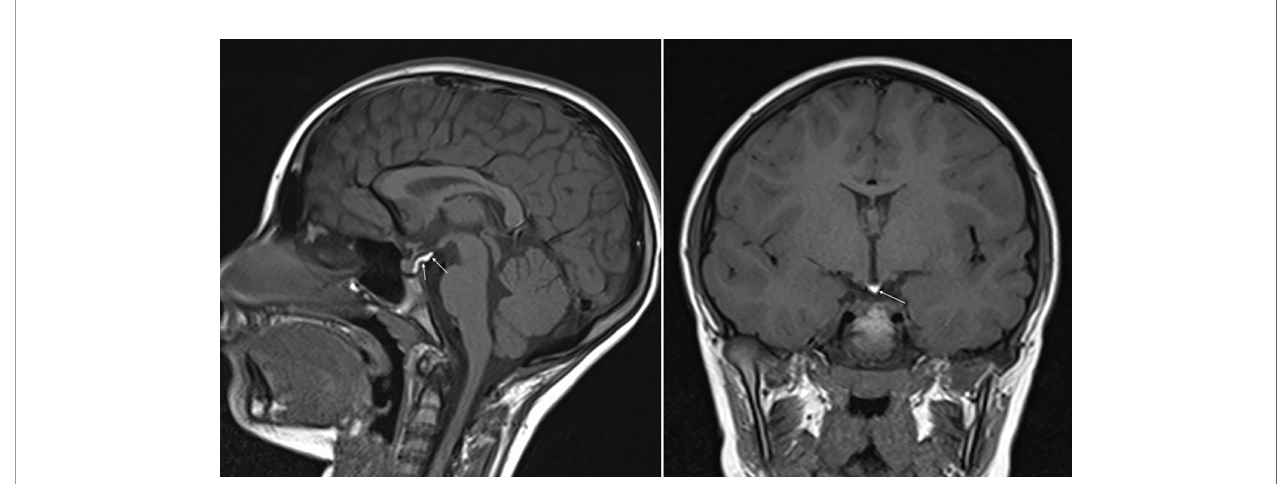
FIGURE 1 | SE T1w sequences (sagittal on the left and coronal on the right) show a posterior bright spot of neurohypophysis increased in size and stretched